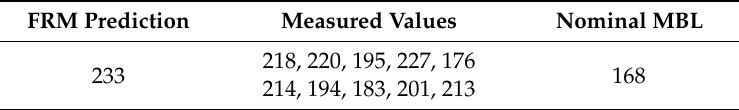
Table 7. Predicted, measured and nominal break loads,